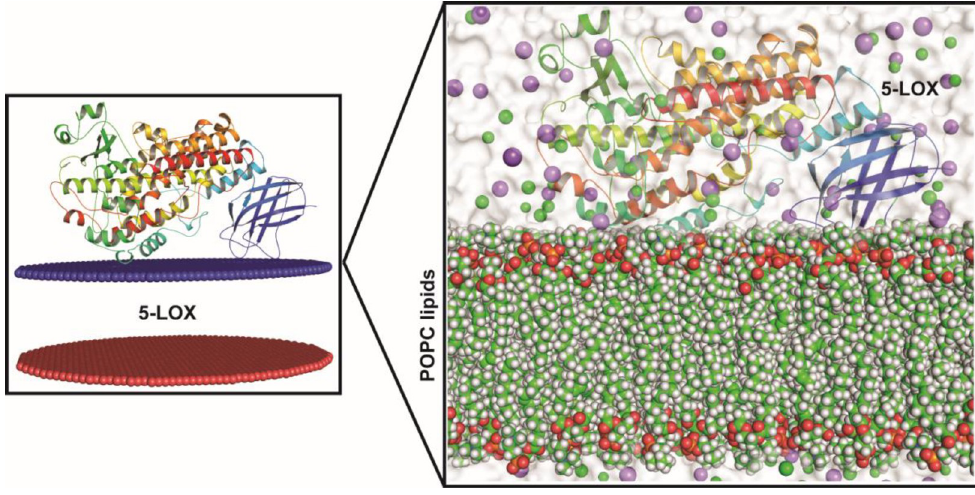
Fig 3. The membrane aligned view of the complete 5-LOX protein and membrane protein (shown in cartoon representation) on the surface of POPC lipid bilayer (waters shown in surface format (white), lipids in sphere format, and lipid head groups in red sphere).